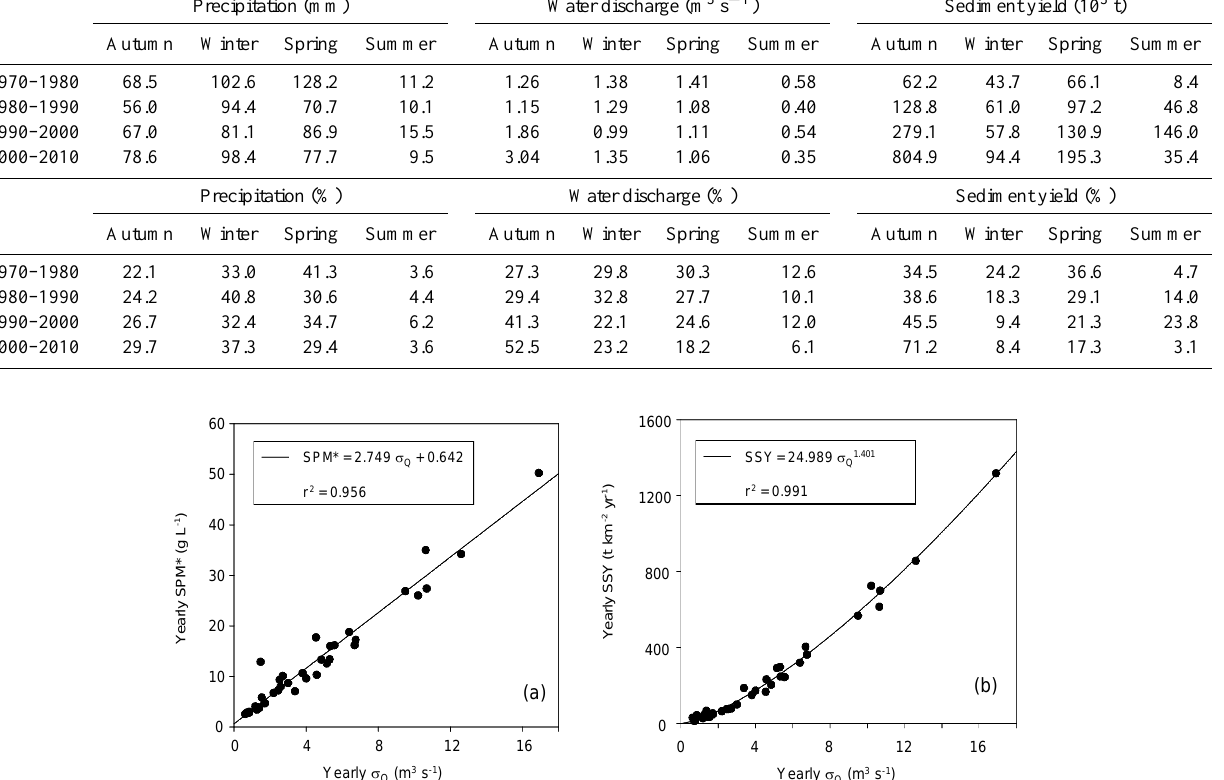
Table 3. Variation of precipitation, water discharge and sediment yield averaged per season over each decade.